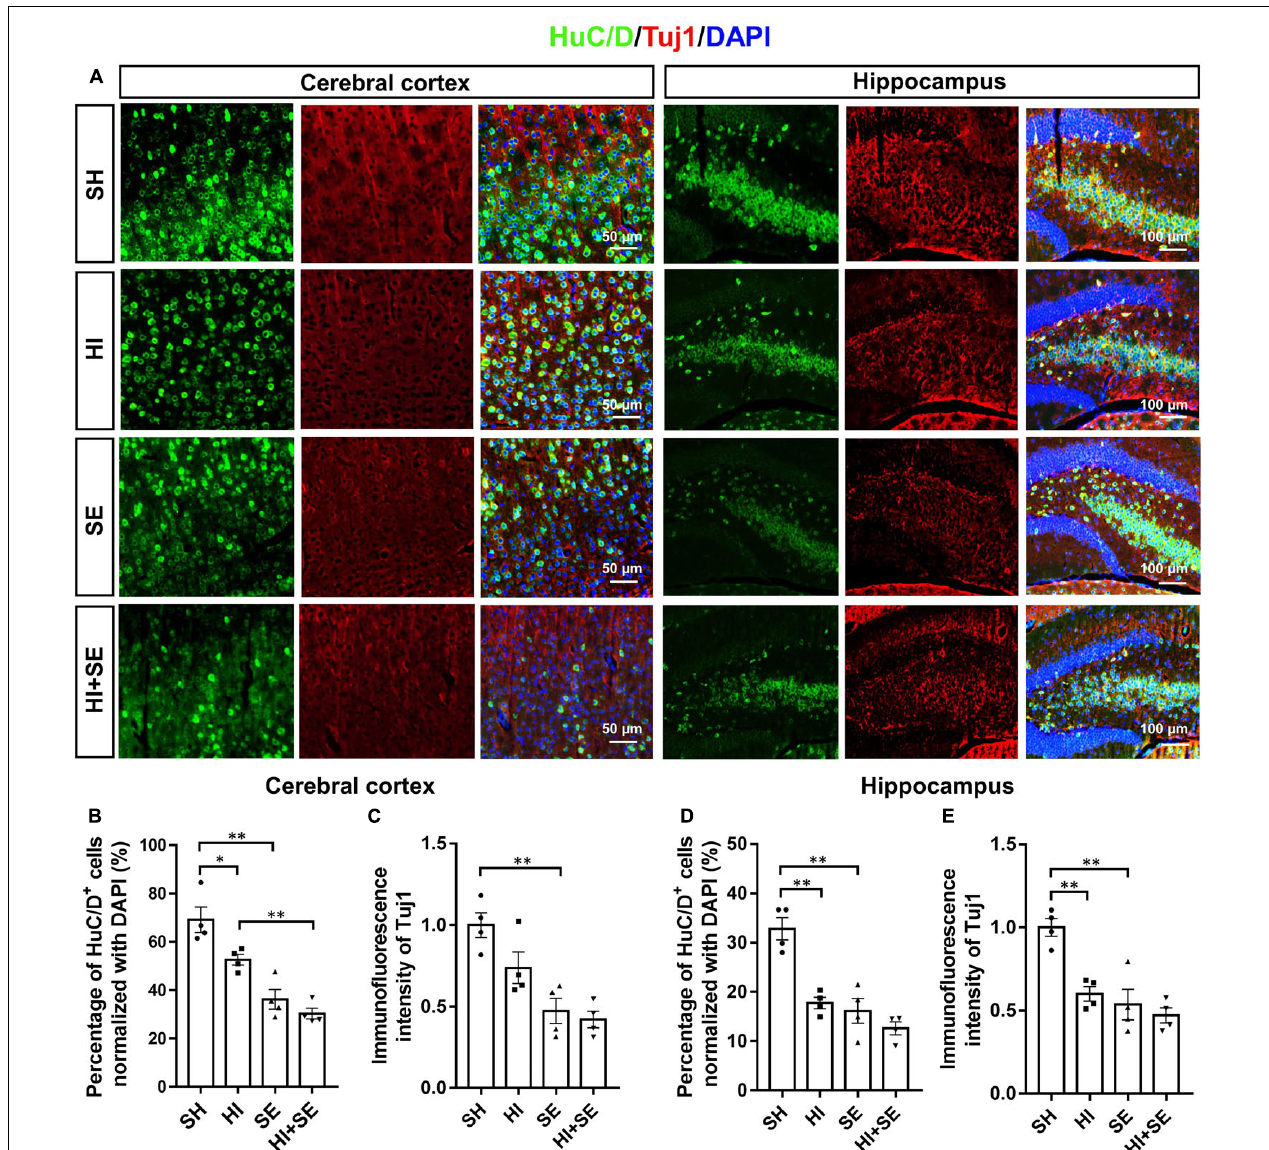
FIGURE 2 | Maternal SE exaggerated HI injury induced neuronal loss. Representative images of immunofluorescence staining of HuC/D and Tuj1 in the cerebral cortex and hippocampus (A) . Percentage of HuC/D immunoreactive (HuC/D + ) cells (B,D) and immunofluorescence intensity of Tuj1 (C,E) in the cerebral cortex and hippocampus. Results are presented as mean ± SEM. ∗ P < 0.05, ∗∗ P < 0.01, n = 4, analyzed by two-way ANOVA followed by post hoc Turkey tests. SH, from sham exposed dams with sham surgery; HI, hypoxic-ischemic injury; SE, from smoke exposed dams with sham surgery; HI + SE, from smoke exposed dams with hypoxic-ischemic